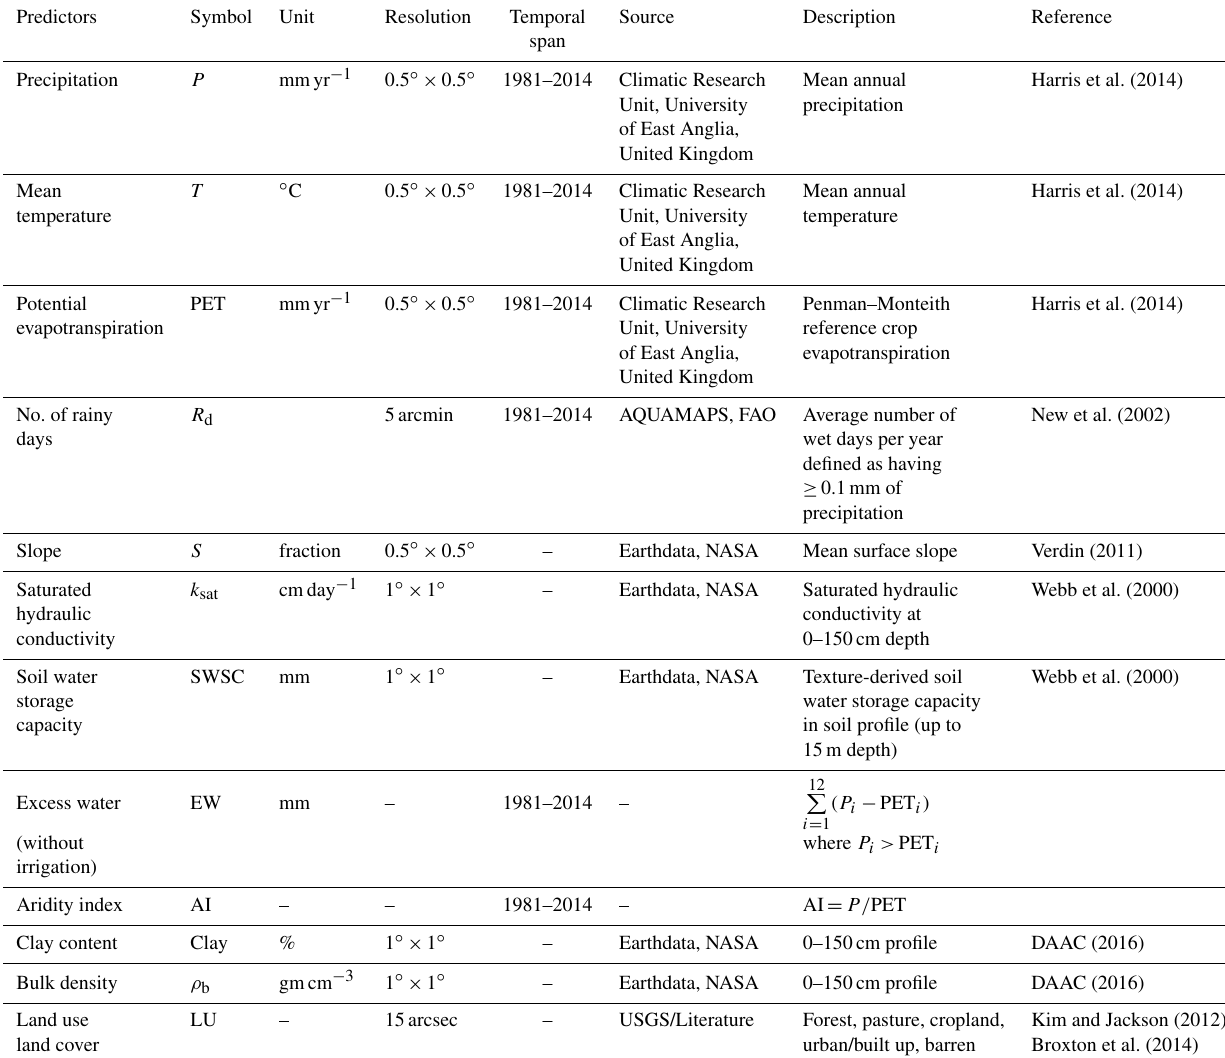
Table 1. Description of predictors used for recharge model